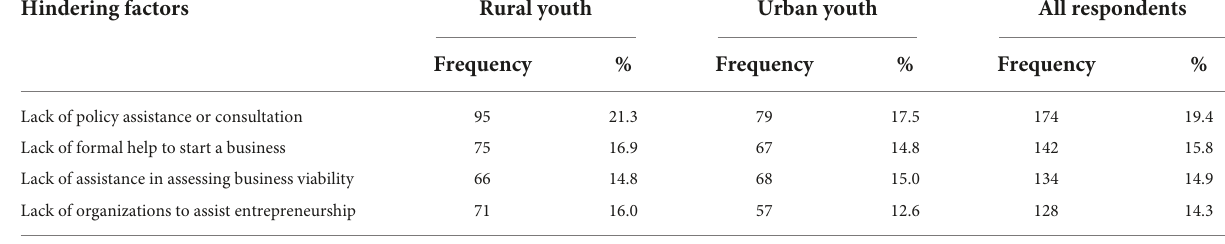
TABLE 8 Family and